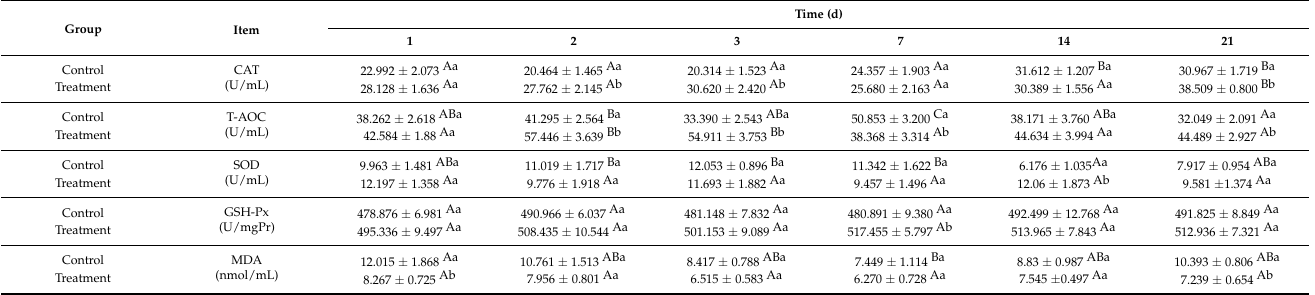
Table 5. The effects of experimental feed on antioxidant capacity in milk of perinatal female